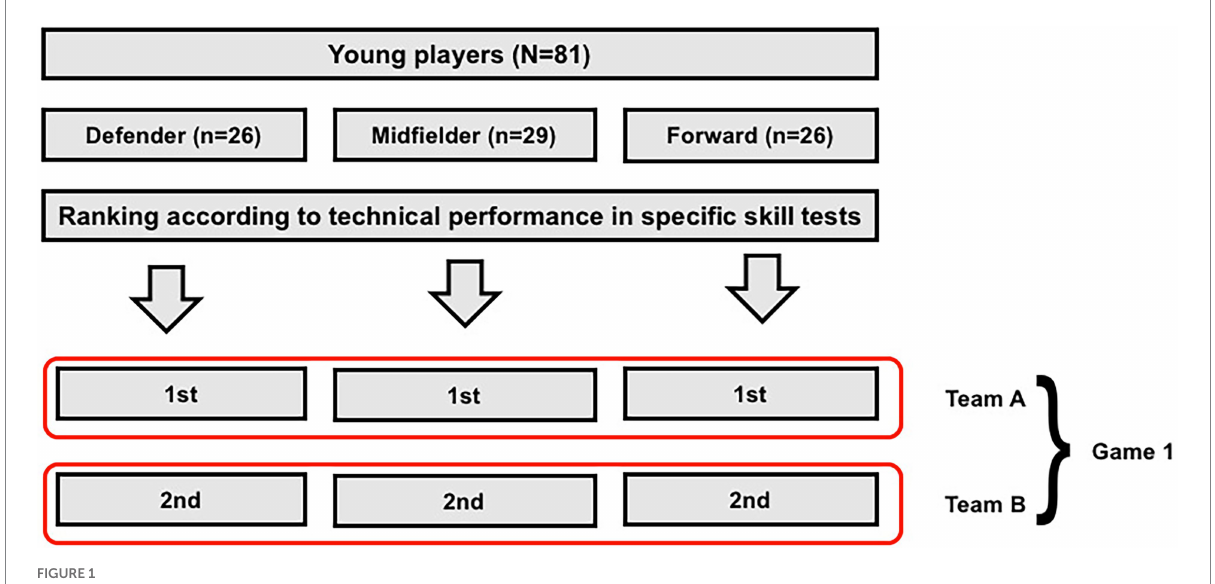
FIGURE 1 Team composition criteria adopted in this